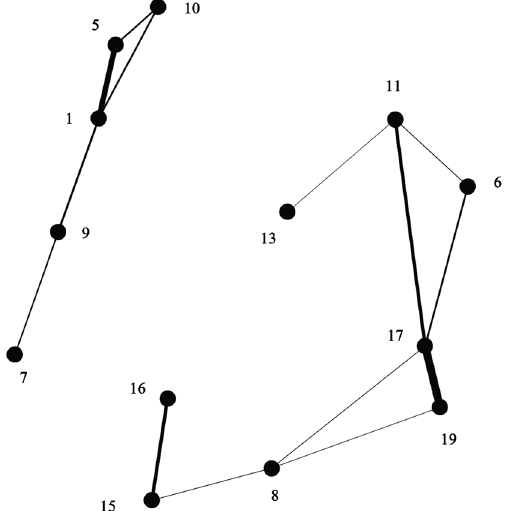
Fig. 4 Initial network (a) First, the primary logistics nodes that have not been added to the initial network are randomly joined to the network.